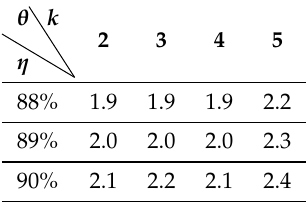
Table 3. The η value and the matching θ value in different